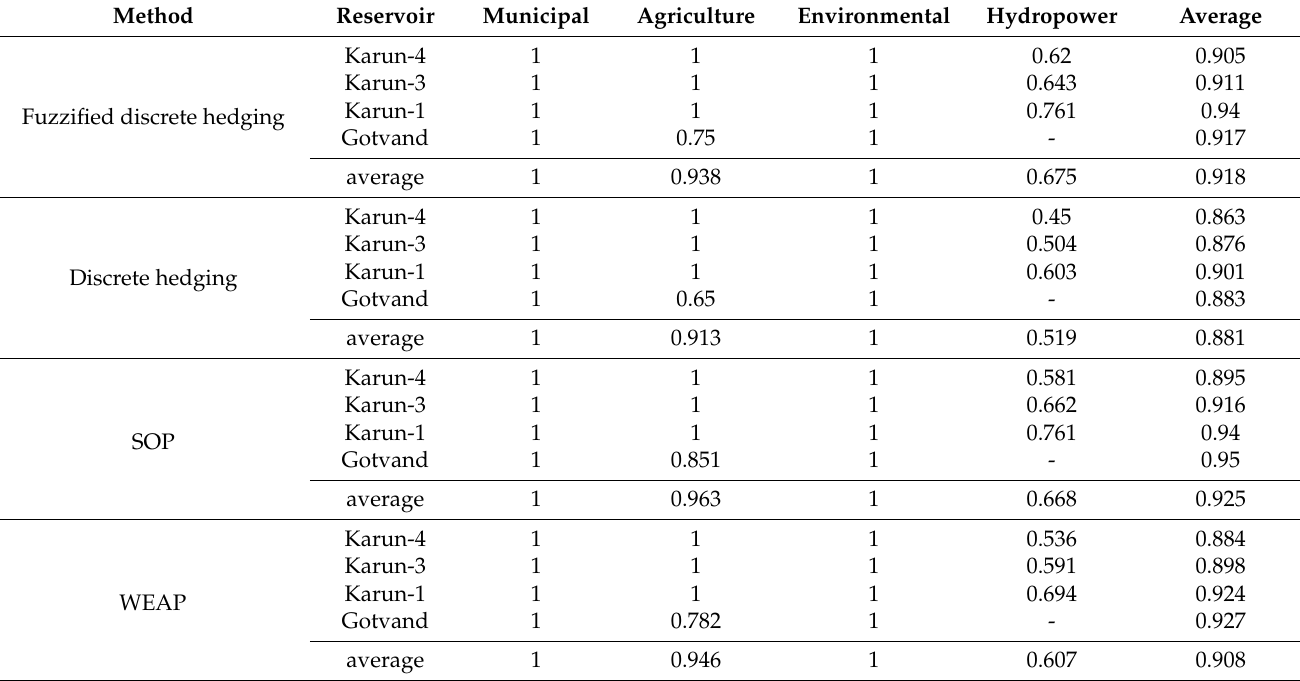
Table 5. Average monthly reliability for the test period assuming a drought and water transmission scenario.